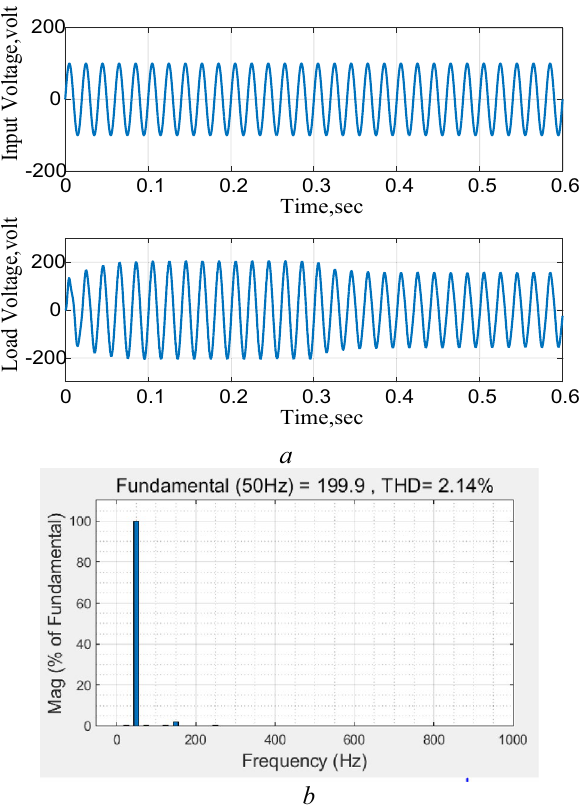
Figure 11. Response to a 25% step reduction in the reference voltage, AC–AC. ( a ) Input and output voltages, ( b ) total harmonic distortion